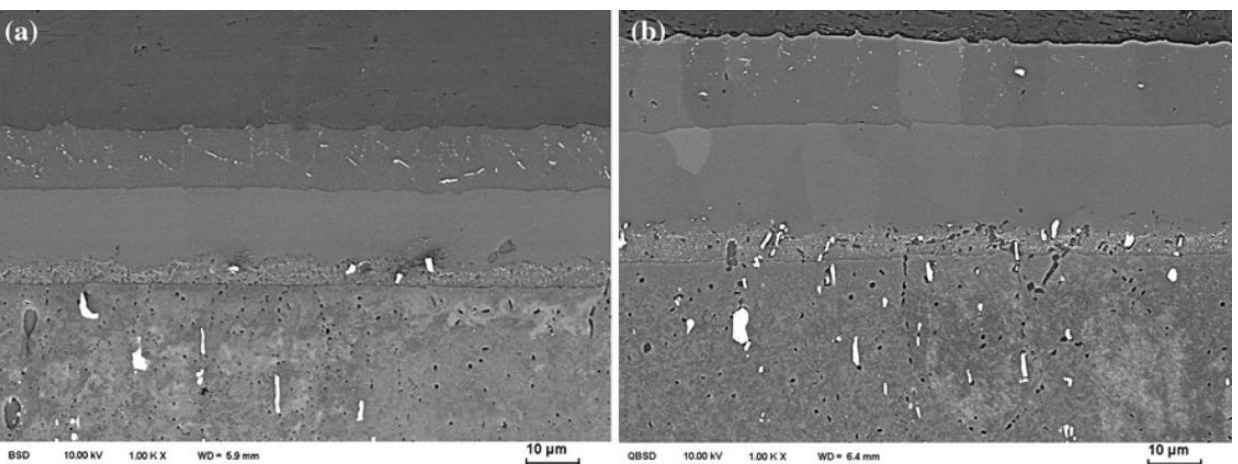
Figure 6. Microstructures of Al/Mg diffusion welded joint at different temperatures